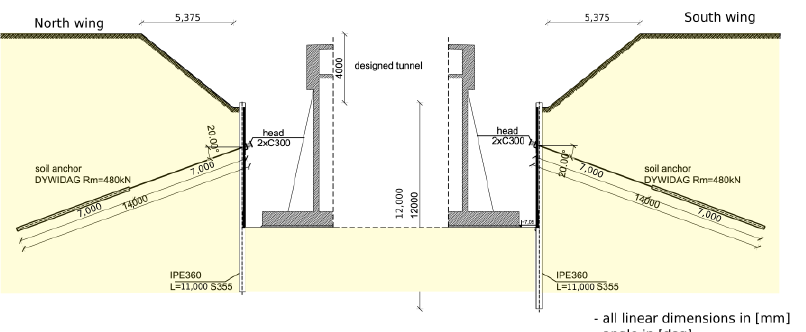
Figure 7. Details of excavation protection: design phase, with location of anchors in typical cross-section (linear dimensions are in [mm], angles in [deg]).